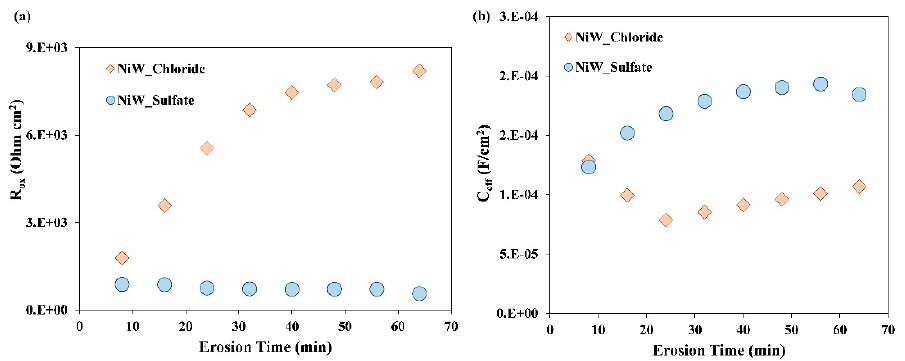
Figure 8. Changes in: ( a ) R ox and ( b ) C eff values for NiW chloride and NiW sulfate coatings during